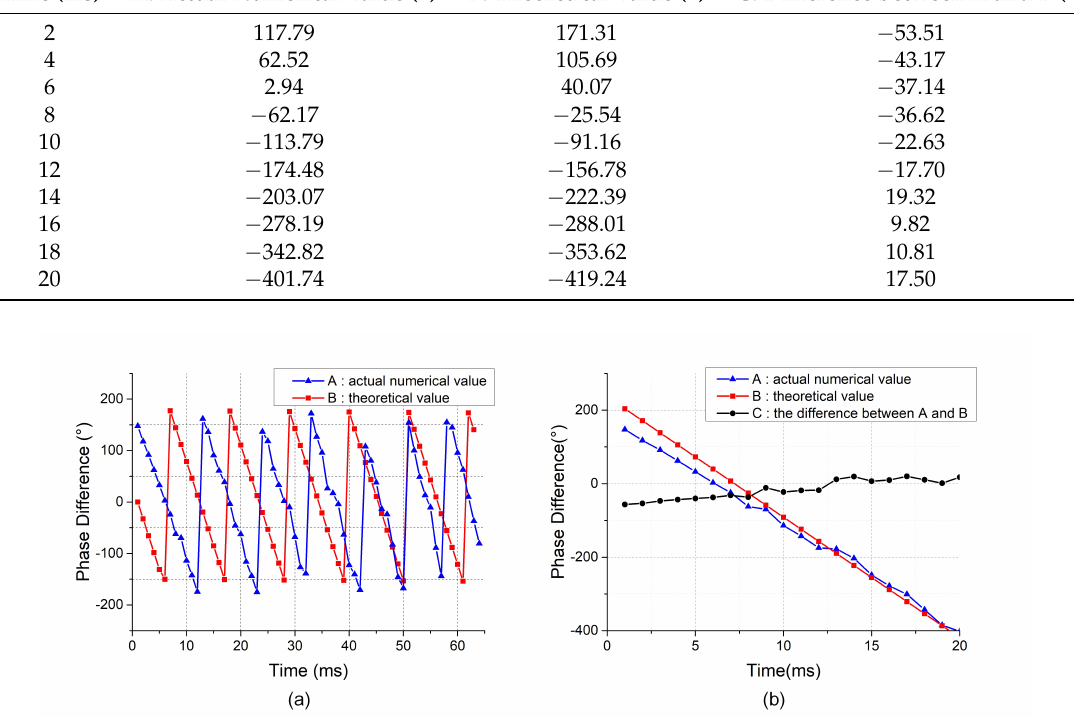
Figure 3. ( a ) Theoretical value and actual numerical value of the phase difference between the scanning signal and the reference signal. ( b ) Phase difference after